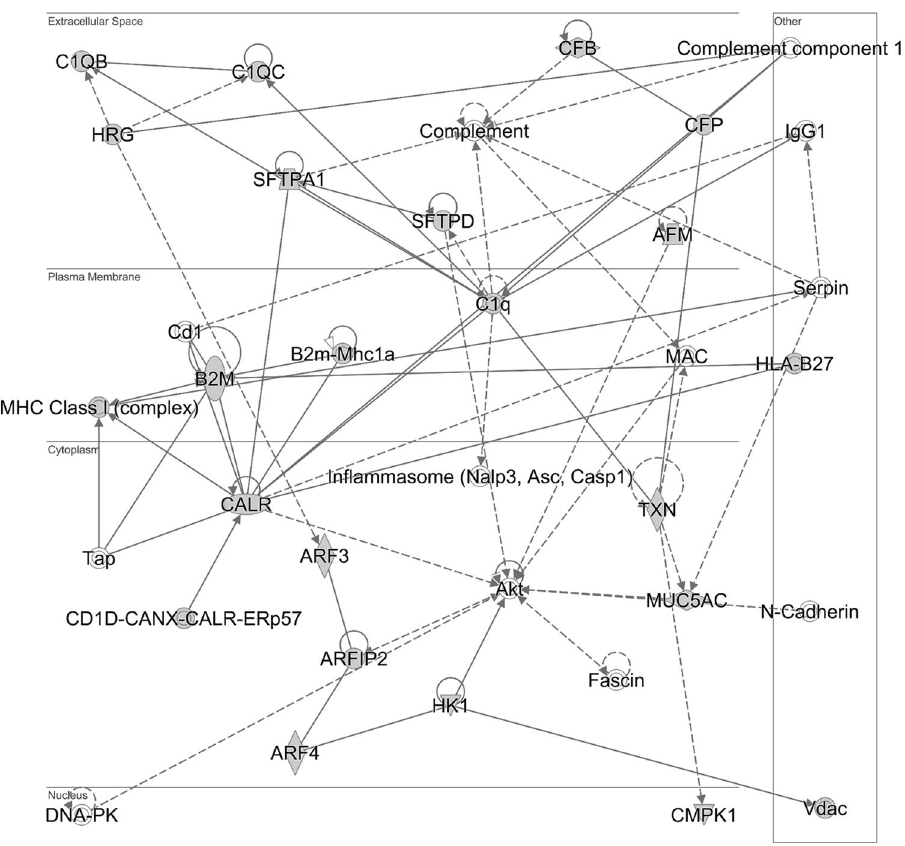
Figure 6. Pathway analysis identifies networks comprising immune-related proteins. Detected proteins are involved in “Cellular Function” and “Maintenance”, “Humoral Immune response” and “Inflammatory Response”. The network is displayed graphically as nodes (proteins) and edges (the biological relationships between nodes). Analysis was performed by the Ingenuity Pathway Analysis software (IPA Spring 2021 release, https:// www. qiage nbioi nform atics. com/ produ cts/ ingen uity- pathw ay- analy sis) 30